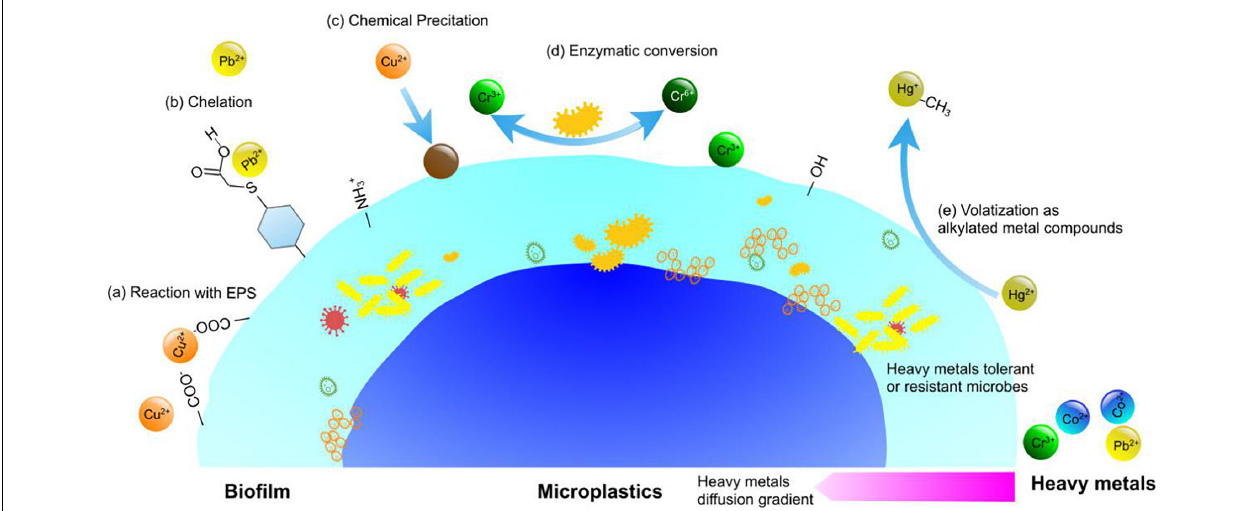
FIGURE 4 | Mechanisms of biofilm involved in the interactions between MPs and heavy metals. (a) Reaction with extracellular polymeric substance (EPS) in the matrix; (b) chelation with proteins and peptides; (c) precipitation via chemical or biological agents; (d) enzymatic conversion; (e) volatilization as alkylated metal